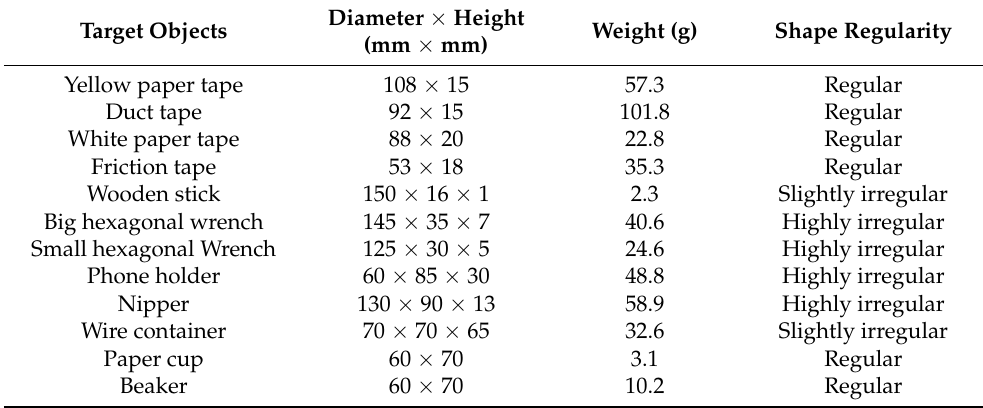
Table 4. Properties of the target